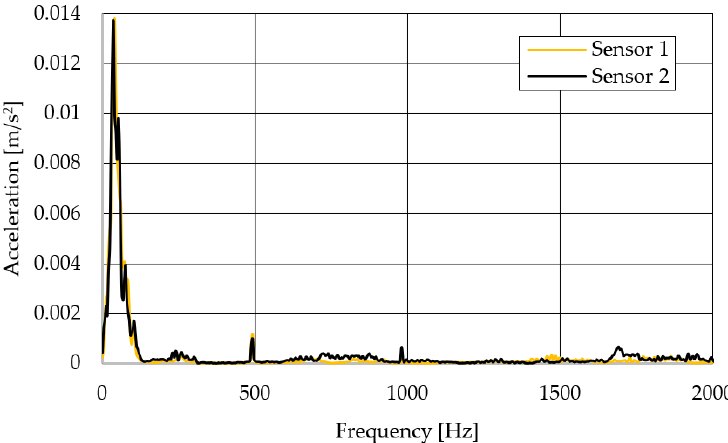
Figure 18. Comparison of the frequency waveforms in the y -axis during symmetrical crossing over the obstacles.